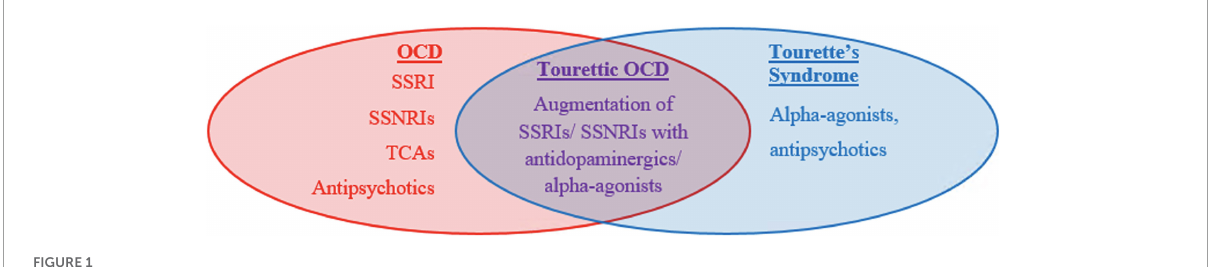
FIGURE1 Similarities and differences in the pharmacologic management of tic disorders and